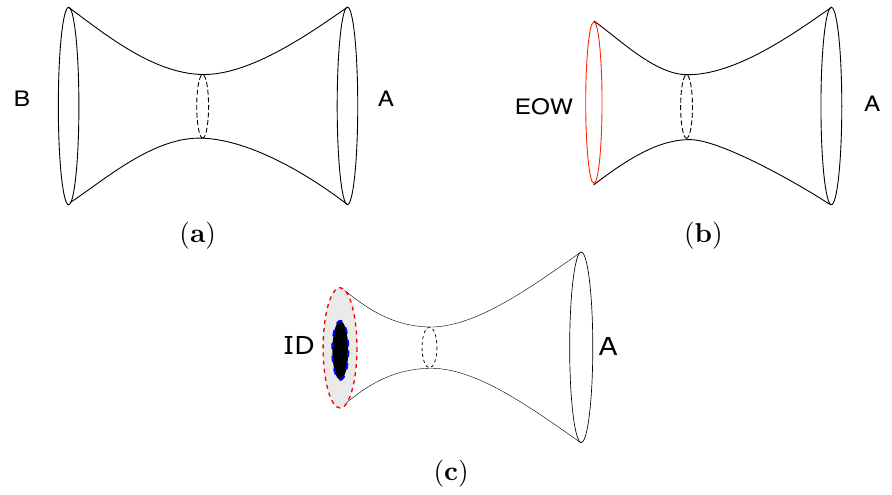
Figure 1 . ( a ) The time-re(cid:13)ection-symmetric slice of the eternal BTZ black hole is a wormhole between two asymptotic regions, A and B . The dashed circle is the bifurcate horizon. This geometry is dual to the thermo(cid:12)eld double state. ( b ) The two-sided wormhole with one side truncated and replaced with an EOW brane (red circle) at a (cid:12)nite distance from the bifurcate horizon. In our model the EOW brane has an internal state structure which matches that of a 2d CFT. ( c ) The EOW brane can be replaced with its holographic dual geometry. When the brane CFT is in a thermal state above the Hawking-Page transition, this geometry is a black hole within the inception disk (ID, gray) which is glued to the original geometry at the location of the brane (dashed red circle). The entropy associated with the brane is proportional to the area of the black hole horizon in the inception disk. This \inception horizon"(dashed blue circle) is an extremal surface homologous to the asymptotic region A . As such, it competes with the usual bifurcate horizon (dashed black circle) when we use the RT formula to search for the minimal surface which computes the entropy of A . In other words, the homology constraint in the RT formula can be satis(cid:12)ed by pulling curves through the circle where the inception disk meets the real